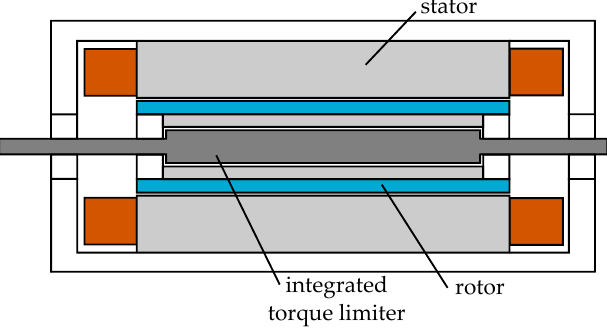
Figure 22. Concept of radially engaging torque limiter.